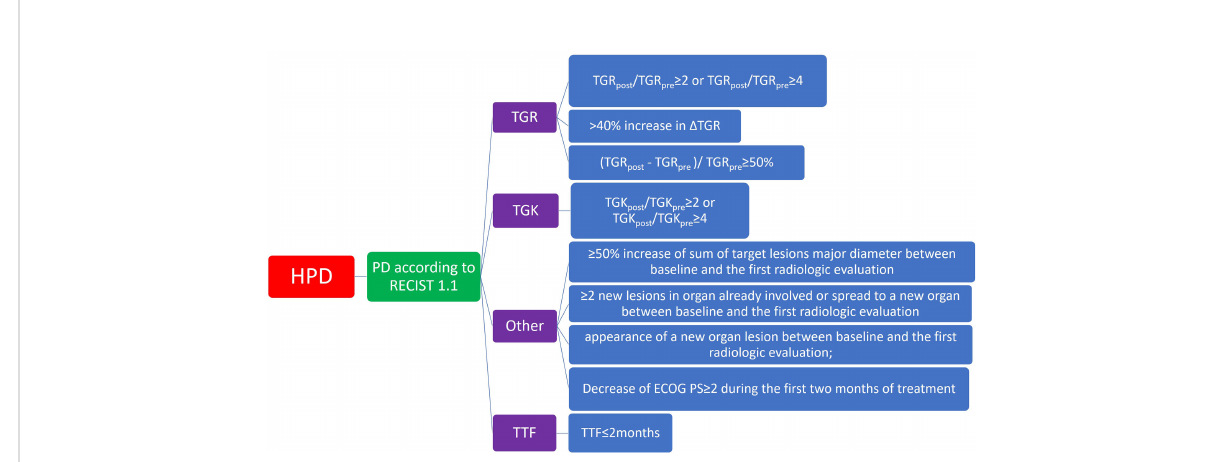
FIGURE 2 Diagram of category of major de fi nition of hyperprogressive diseases in included studies. ECOG PS, Eastern Cooperative Oncology Group Performance Score; HPD, hyperprogressive disease; PD, progressive disease; RECIST, Response evaluation criteria in Solid Tumors; TGK, tumor growth kinetics; TGR, tumor growth rate; TTF, time to treatment